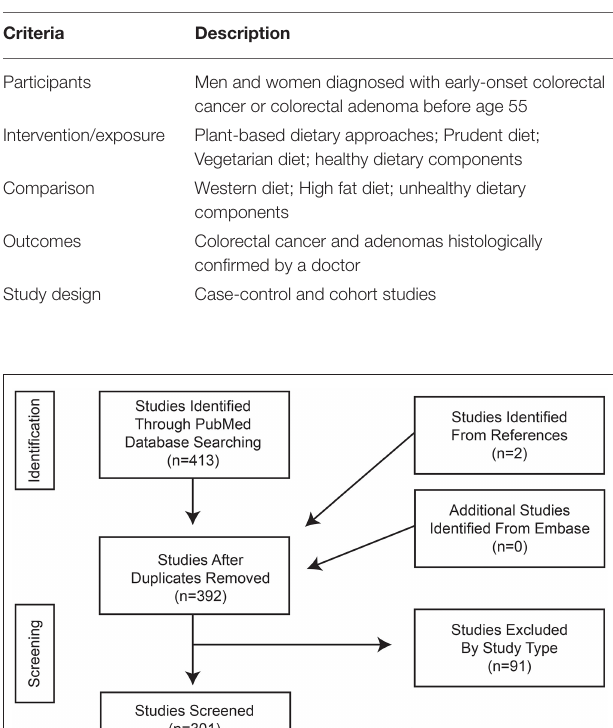
TABLE 1 | The population, interventions, comparators, outcomes and study designs (PICOS) scheme used for assessing eligibility.